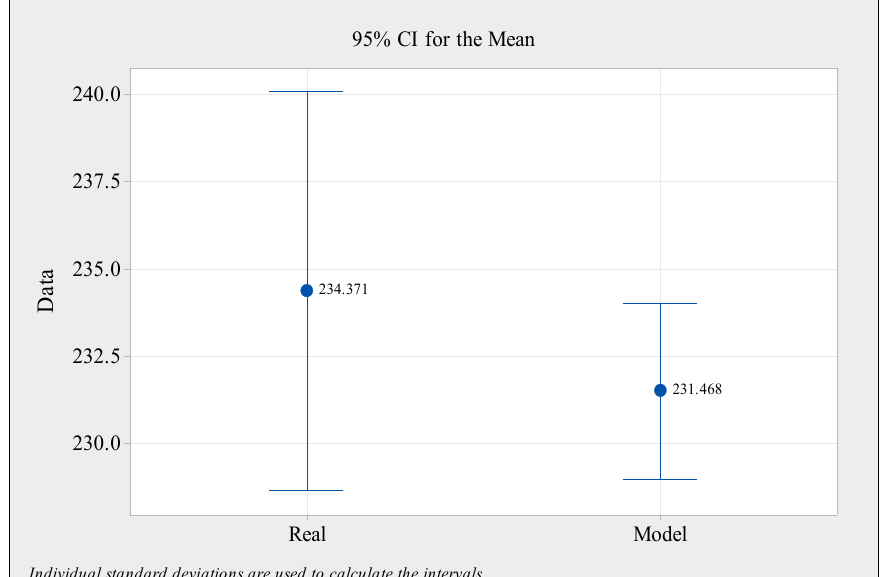
Figure 7. Comparison between the actual and simulated model in the number of patients served by the system.